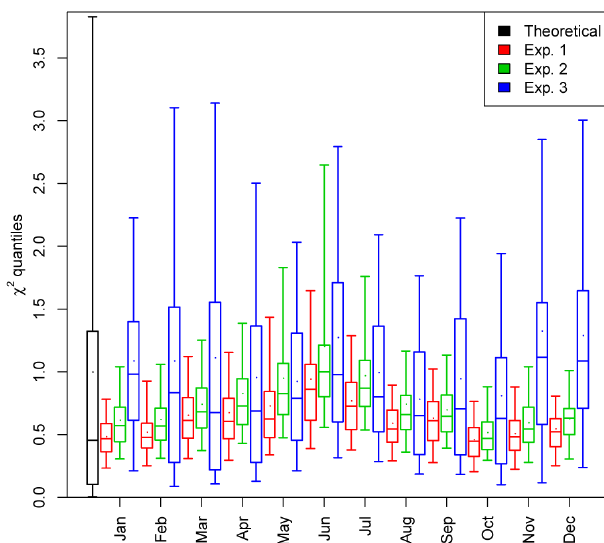
Fig. 2. Box-plots for the χ 2 statistic for Exp. 1–3, separated by each month, as well as for the χ 2 distribution. The lower and upper 1 whiskers show the 0.05 and 0.95 quantiles, respectively. The lower bound, centre line and upper bound of the box correspond to the 0.25, 0.5 and 0.75 quantiles, respectively. The dot within each box denotes the mean of the